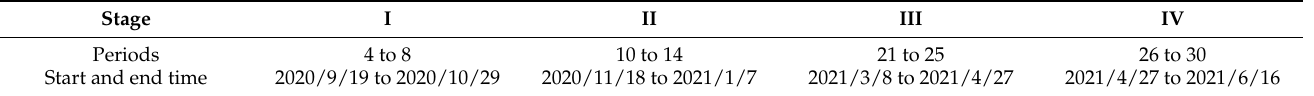
Table 3. Division of characteristic phenology.